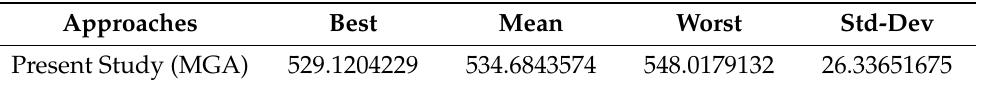
Table 20. Statistical results of the different method for the ten-bar truss bearing design problem.